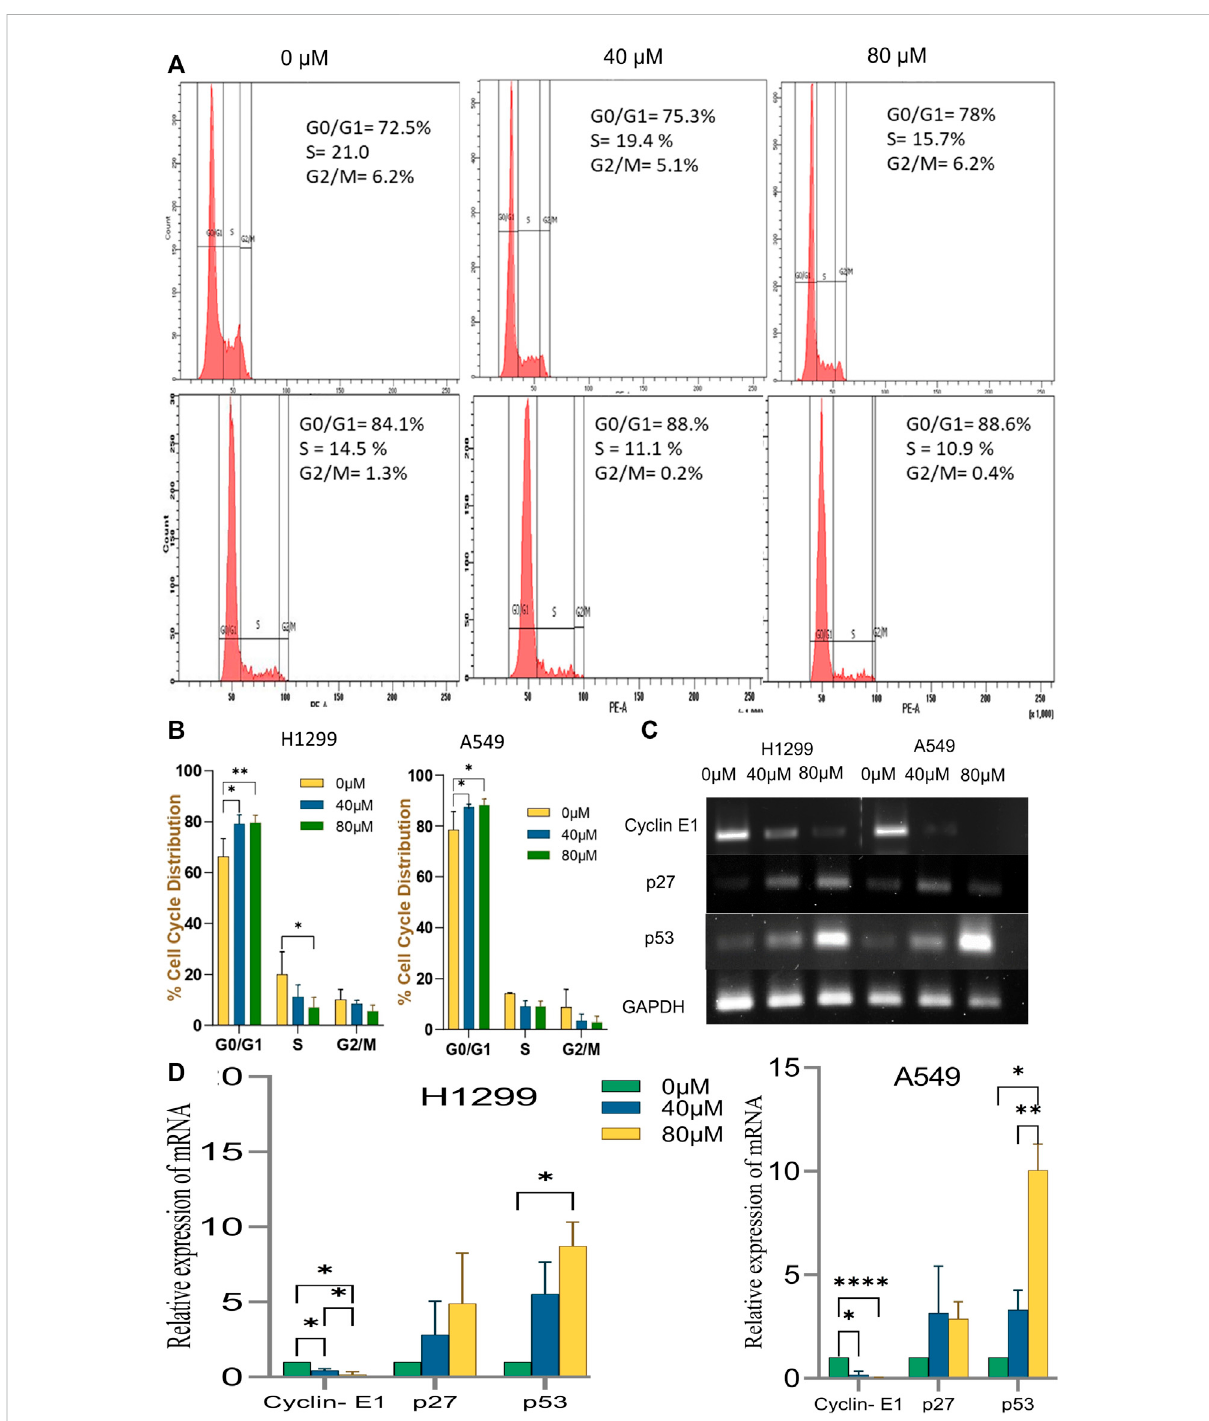
FIGURE 5 Effect of Cell Cycle progression after treatment with 18 α -GA. (A) Flow cytometric images represent the distribution of H1299 and A549 cells at different stages of the cell cycle. (B) % cell cycle distribution measured by FACS ( n = 3, mean ± SD), statistical analysis was done by 2-way Anova followed by Tukey ’ s Post-hoc multiple comparison test. * p < 0.05, ** p < 0.01, *** p < 0.001, **** p < 0.0001. (C) The mRNA expression of related genes after treatment with 18 α -GA by RT-PCR. (D) Graph representing mRNA expression levels of genes with respect to GAPDH, statistical analysis was done by 2-way ANOVA followed by Tukey ’ s Post-hoc multiple comparison test, * p < 0.05, ** p < 0.01, *** p < 0.001, **** p <